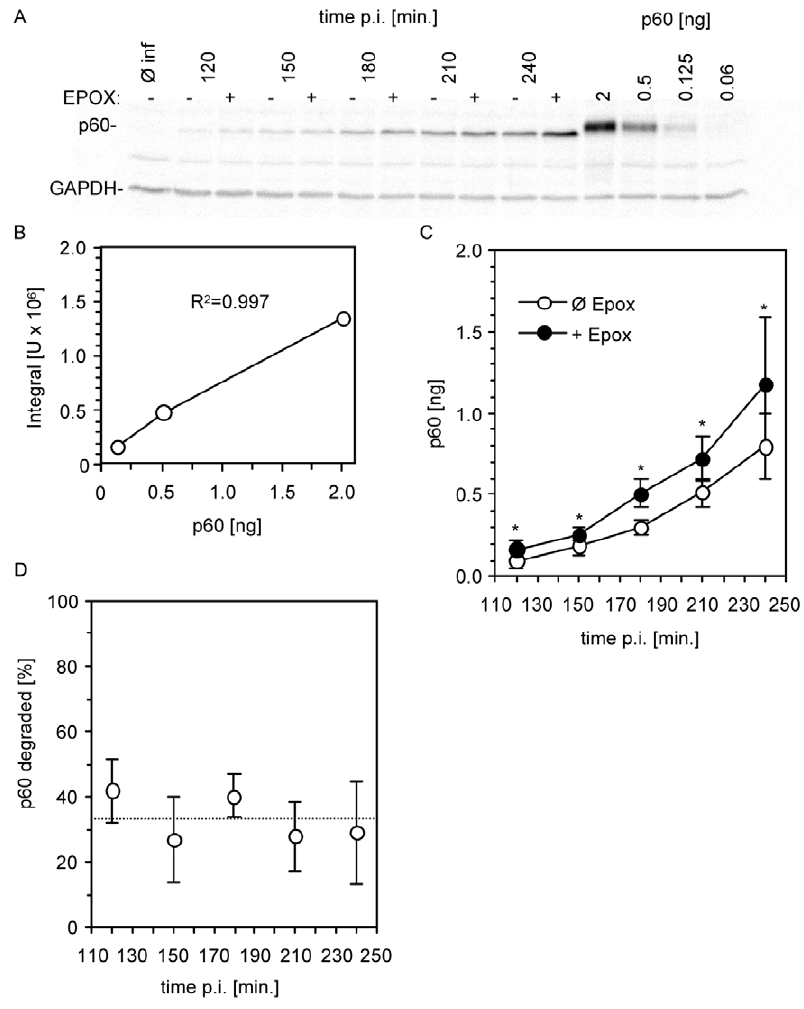
Figure 2. Degradation of p60 in infected cells. Cells were infected with L. monocytogenes in the presence ( + EPOX) or absence (Ø EPOX) of the proteasome inhibitor epoxomicin. At the indicated time points post infection cells were harvested and intracellular p60 was detected by western blotting. Shown is a representative western blot (A). The absolute amount of p60 was quantified by interpolation with an external p60 standard (B). From the total amount of p60 in the presence and absence of epoxomicin (C) the percentage of degraded p60 was calculated (D). The broken line indicates the average percentage of degraded p60 calculated over all five time points (33%). Shown are the means and standard deviations of four independent experiments. Asterisks (*) indicate a statistical significant (p , 0.05) difference between matched values of both experimental groups.